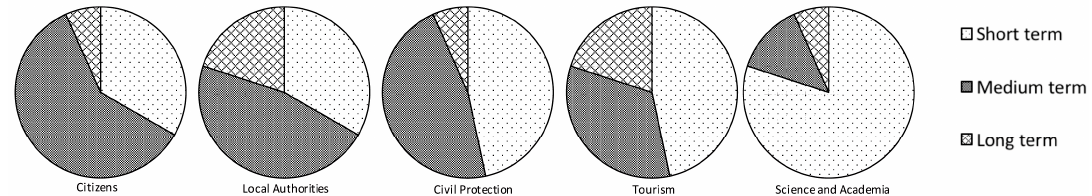
Figure 4. Stakeholder views on the adoption of citizen science initiatives by different communities— citizens, local authorities, civil protection, tourism and science. Short term: less than or equal to three years; Medium term: between three and five years; and Long term: between five and 15 years